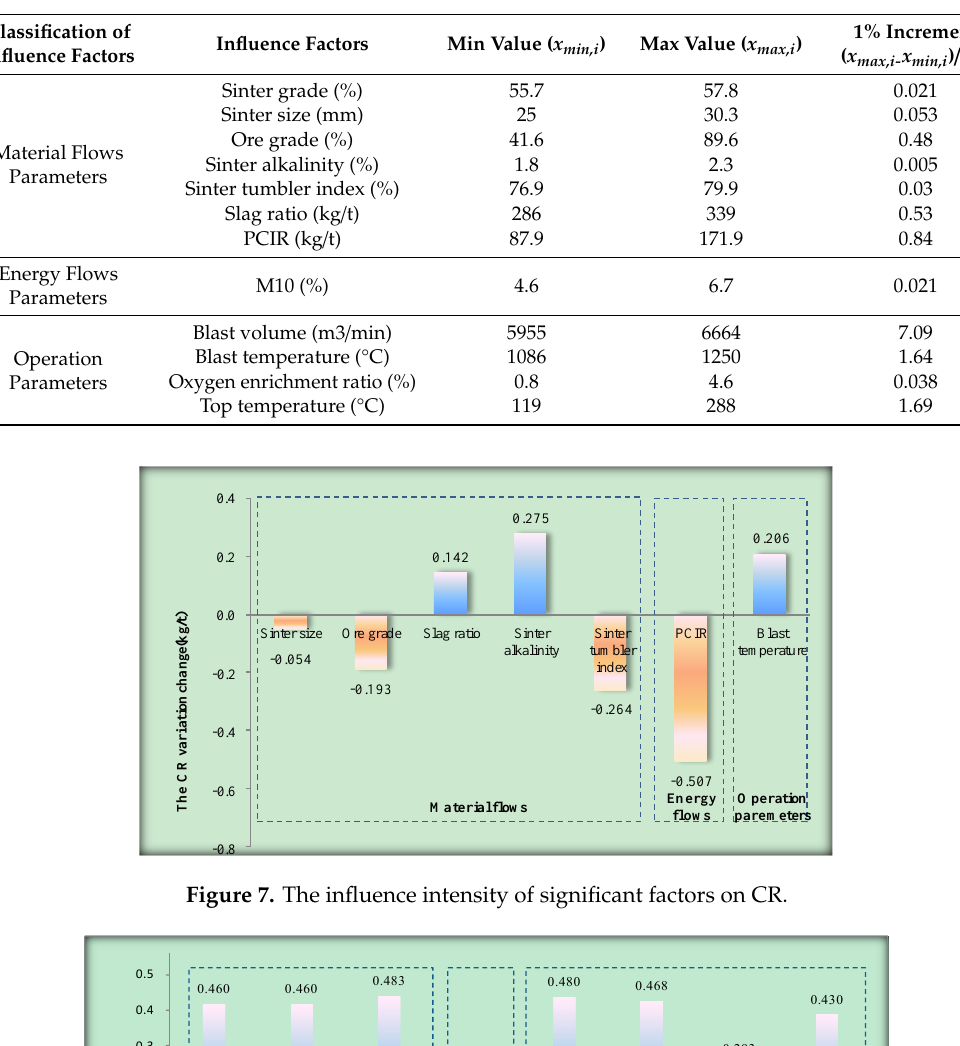
Table 3. The range of the influence factors (independent variable).